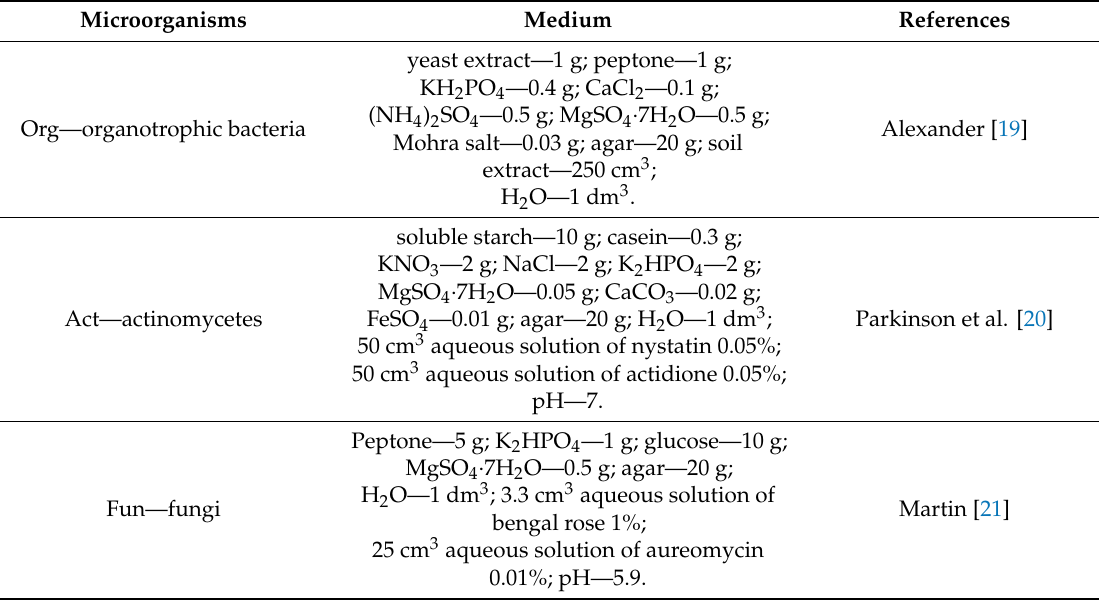
Table 3. Medium for determination of counts of soil